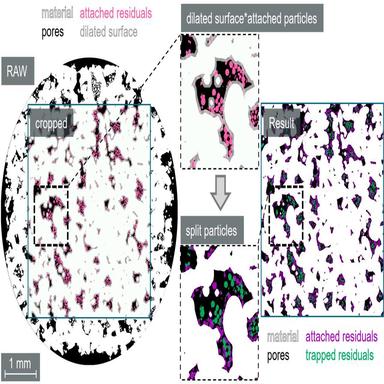
Visualization on how attached and trapped particles are estimated.